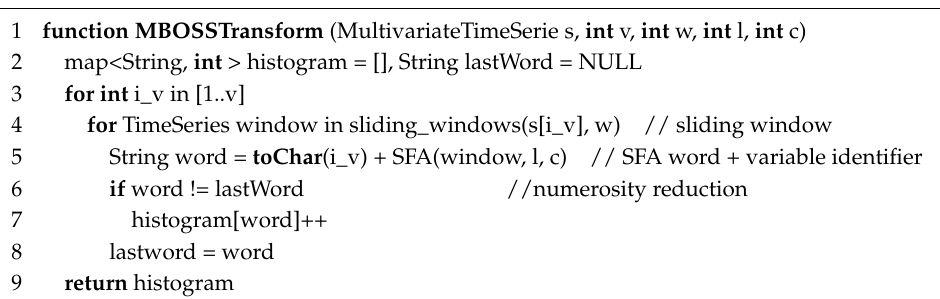
Algorithm 1. MBOSS Algorithm 1. MBOSS Transformation.